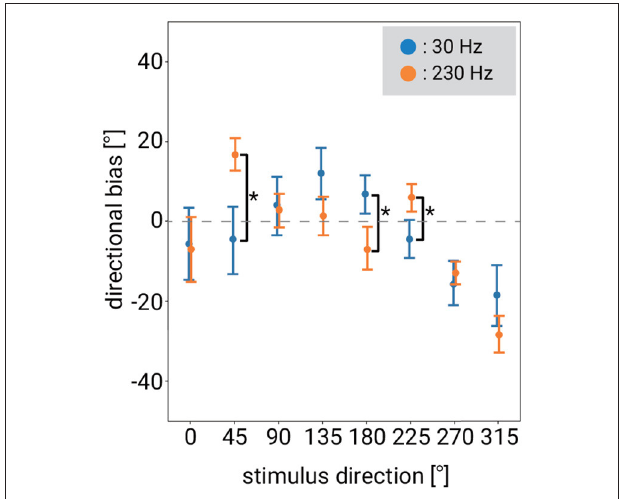
FIGURE 5 | Difference of mean directional biases for each stimulus direction between 30 and 230 Hz. Error bars denote 95%CI. The asterisk indicates significant difference between stimulus